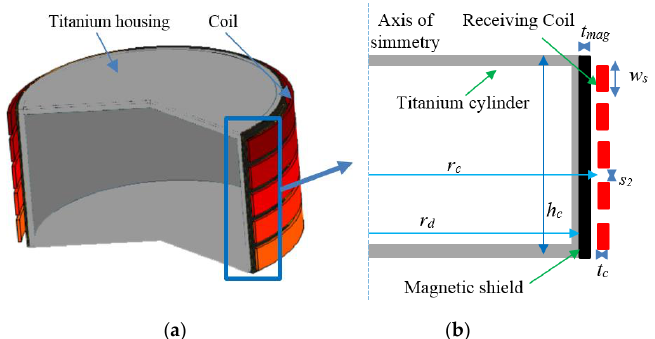
Figure 9. 3D model of the LVAD with secondary coil ( a ) and 2D axially symmetric secondary coil configuration ( b ).